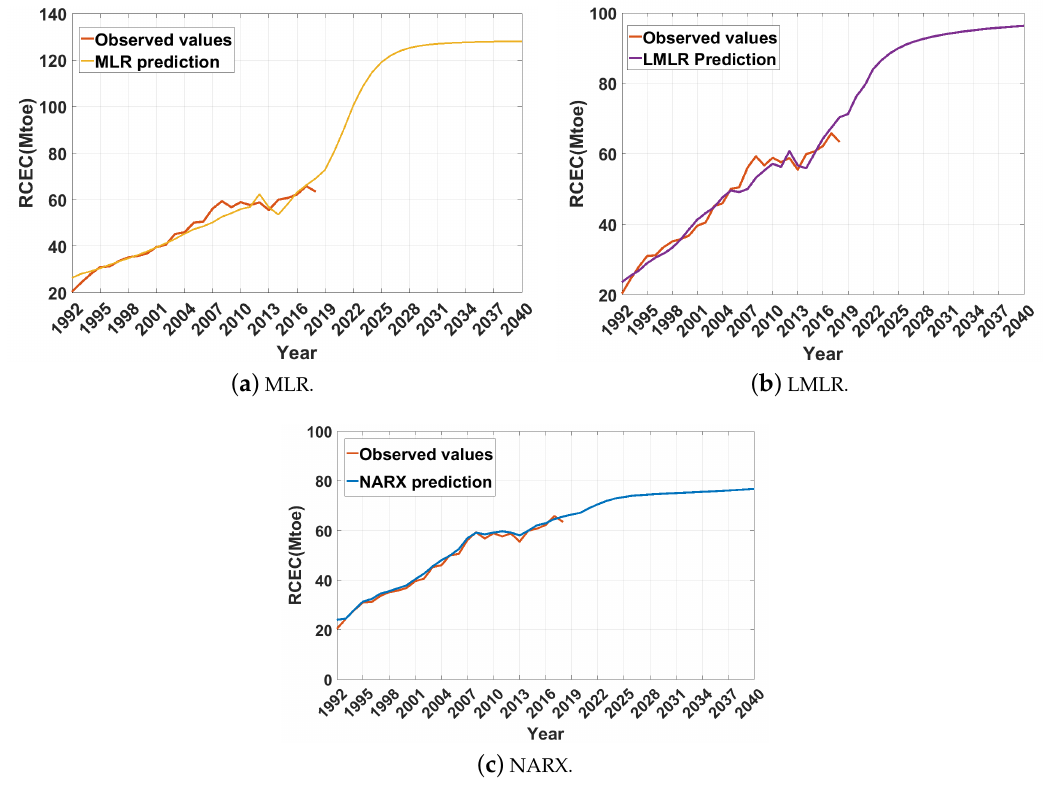
Figure 11. Iranian RCEC prediction by 2040.